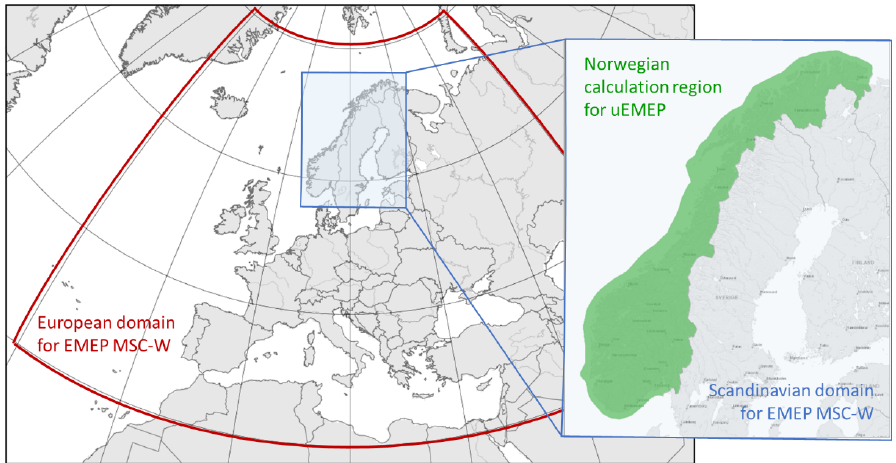
Figure 5. Model domain for the European and Scandinavian EMEP MSC-W calculations and the uEMEP calculations (© kartver-